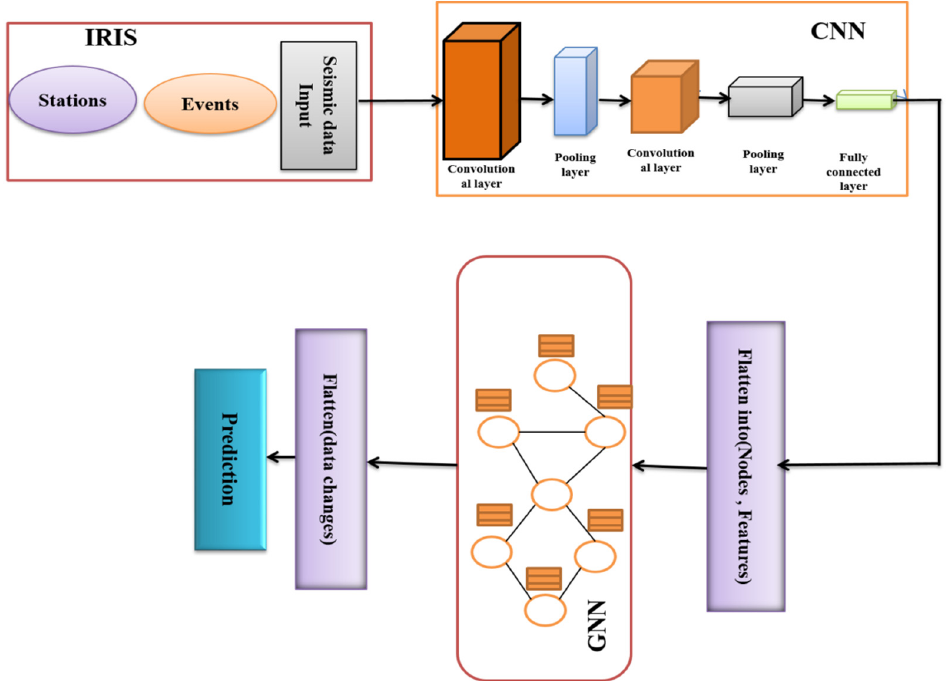
Figure 1. The proposed methodology consists of three components. First, data downloading and preprocessing. Second, CNN part to examine the data to extract the feature map. Third, use extracted future map and combine it with station location information to make a final prediction.